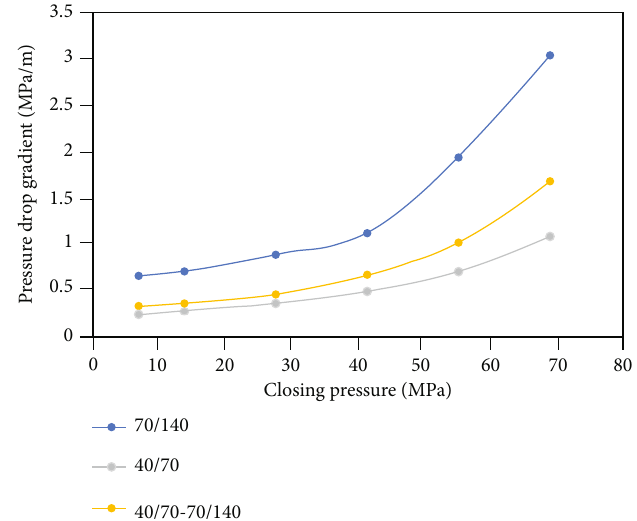
Figure 4: Pressure drop gradient of arti fi cial